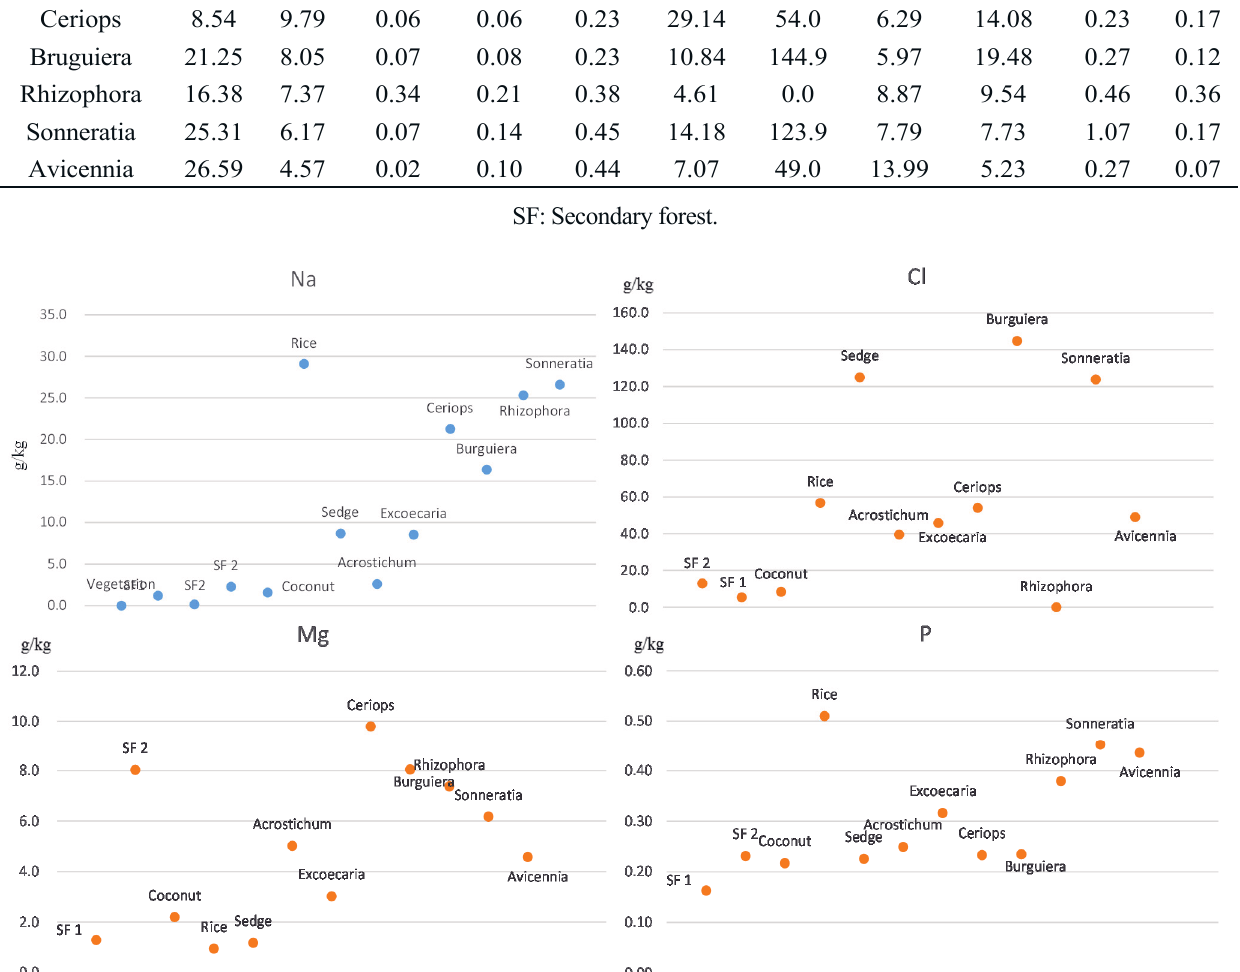
Figure 8. Leaf Na, P, Mg, and Cl contents in different types of vegetation along the transect. SF denotes secondary